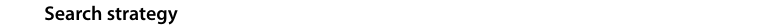
Table 1 Search strategy for each database